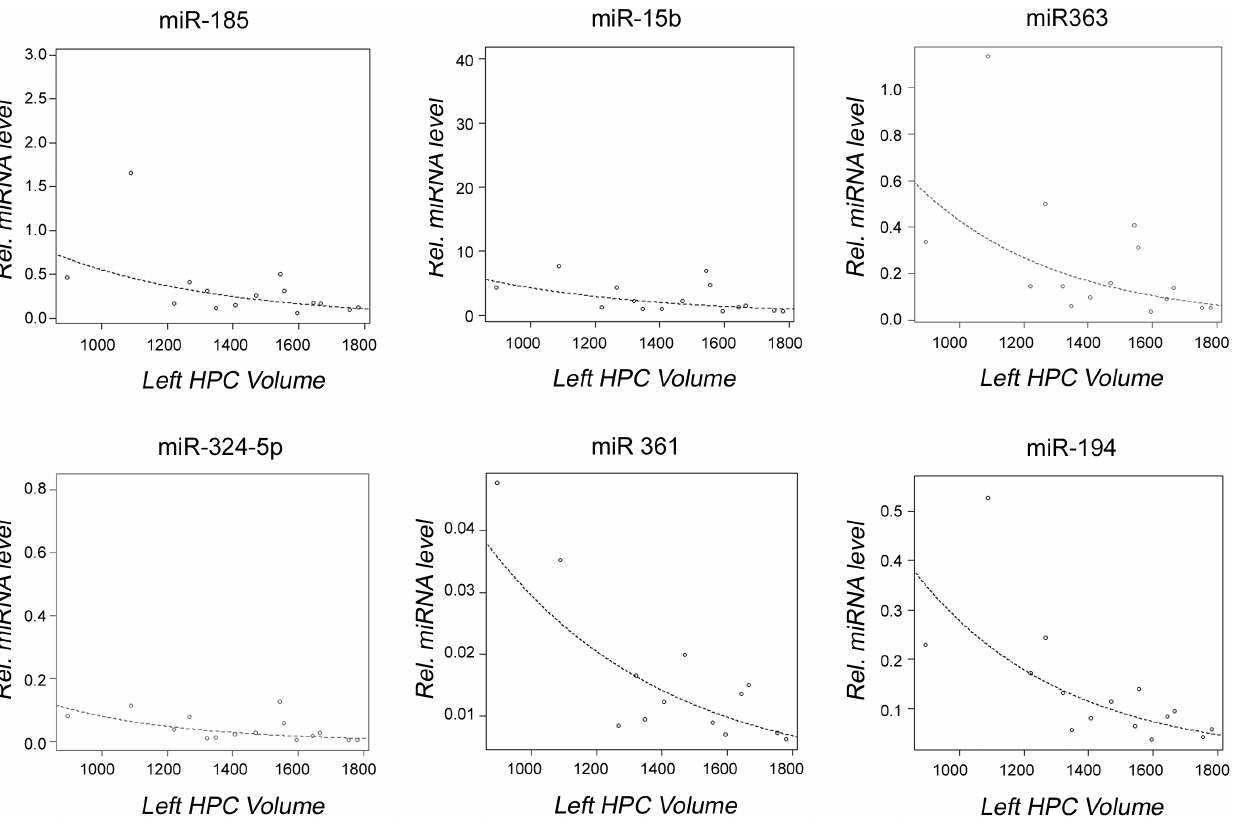
Figure 5. Observed correlation between dysregulated miRNAs and left hippocampal volume. Graphs showing a correlation between miRNA expression levels and left hippocampal volume within the 22q11DS group. Open circles represent individuals with 22q11DS; the line represents line of best fit. P-values given are for correlations.